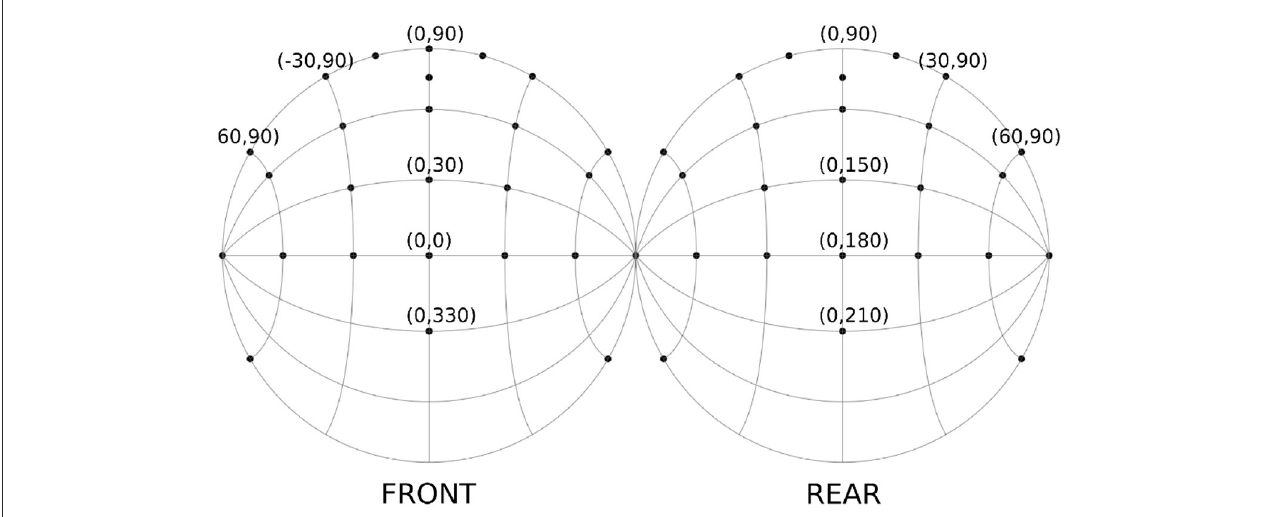
FIGURE1 Spatial directions of the sound sources used in the experiment, plotted as two hemispheres cut through the frontal plane. In total 41 directions were used.